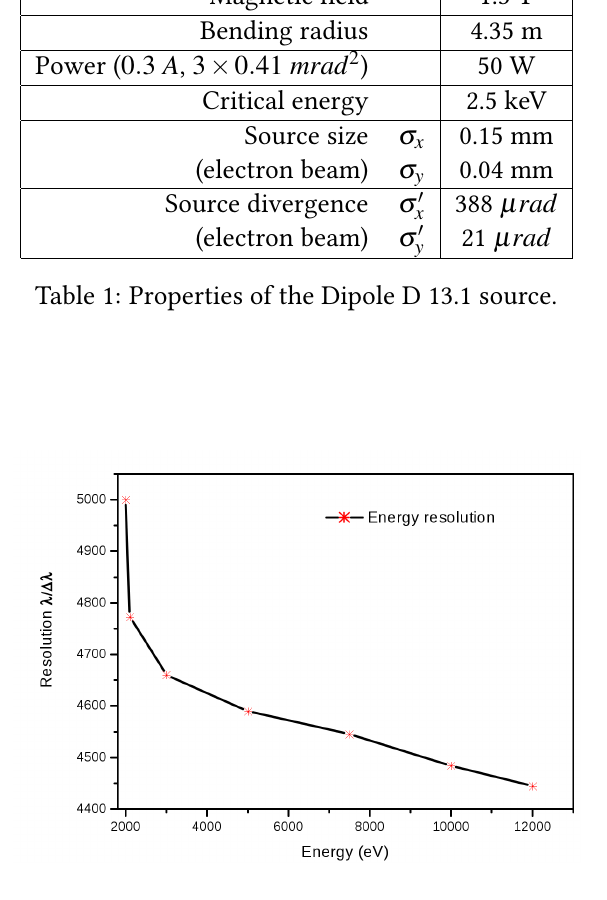
Figure 2: Energy bandwidth of the monochromatic beam.